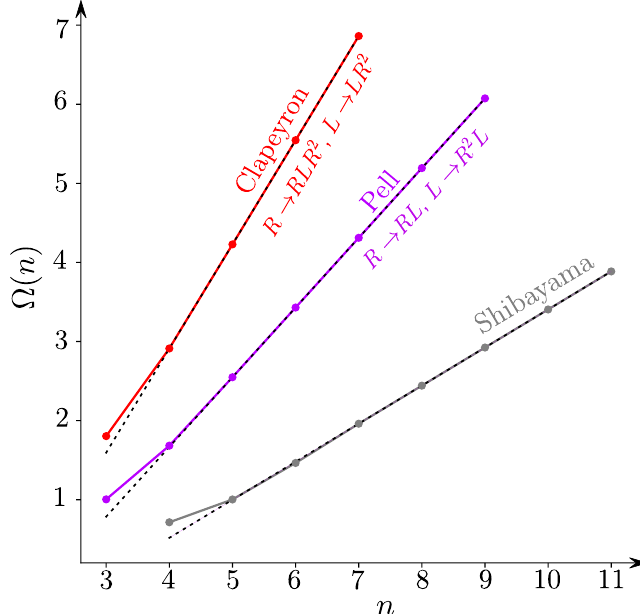
Figure 3: The convergence of the topological entropy in the Pell and Clapeyron cas- cades, and the Shibayama cascade featuring words growing as Fibonacci numbers (Eqs. (81),(89), and (95), respectively). Ω ( n ) = ln [ ln ( h n tion of n , where h corresponds to the topological entropy of the n th word from a n given cascade. Dashed lines are asymptotes of the form a (cid:112) = ln ( h ∞ ) , a = ln ( 2 + (cid:112) and b P C 2 2 = ln ( h ∞ (cid:112) ) , corresponding to the respective b S 5